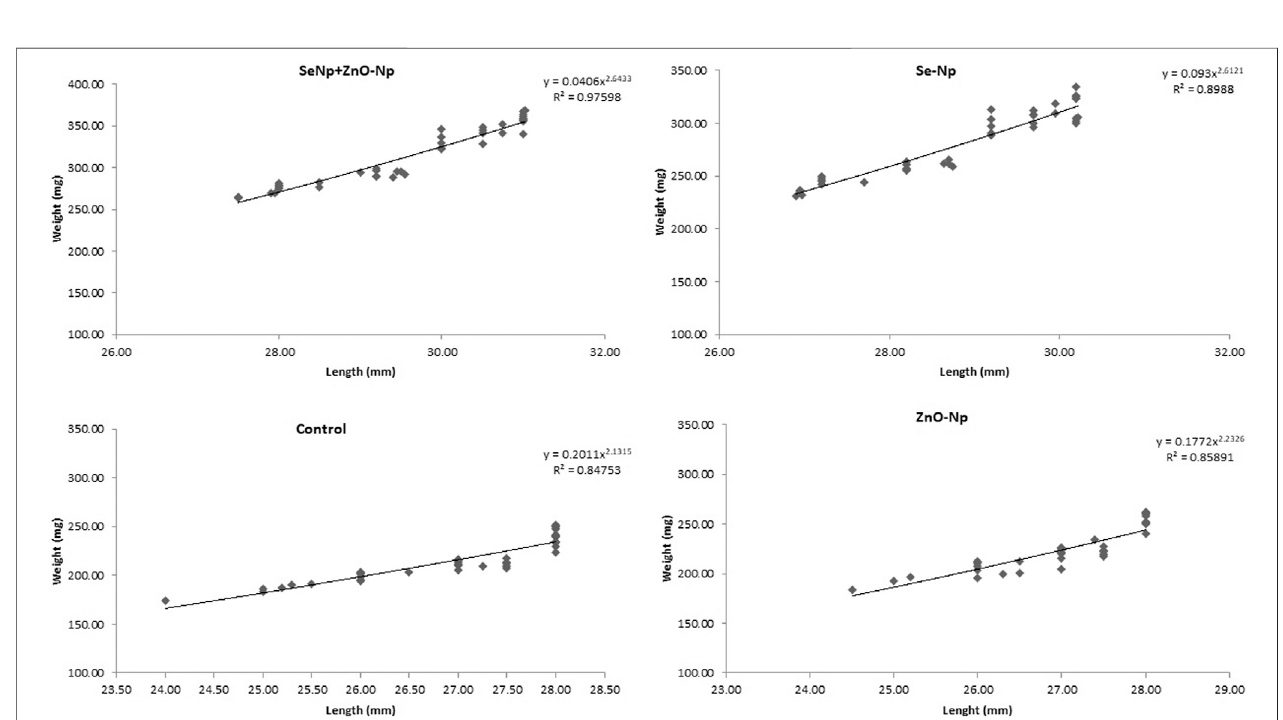
FIGURE 2 | Length – weight relationship of adult zebra fi sh in the four groups: SeNPs + ZnONPs, SeNPs, ZnONPs, and control, showing R 2 as the critical growth parameter value.